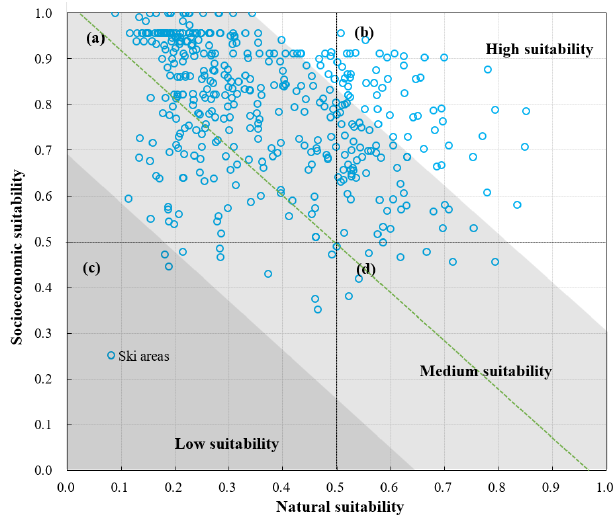
Figure 8. The suitability values of existing ski areas established after